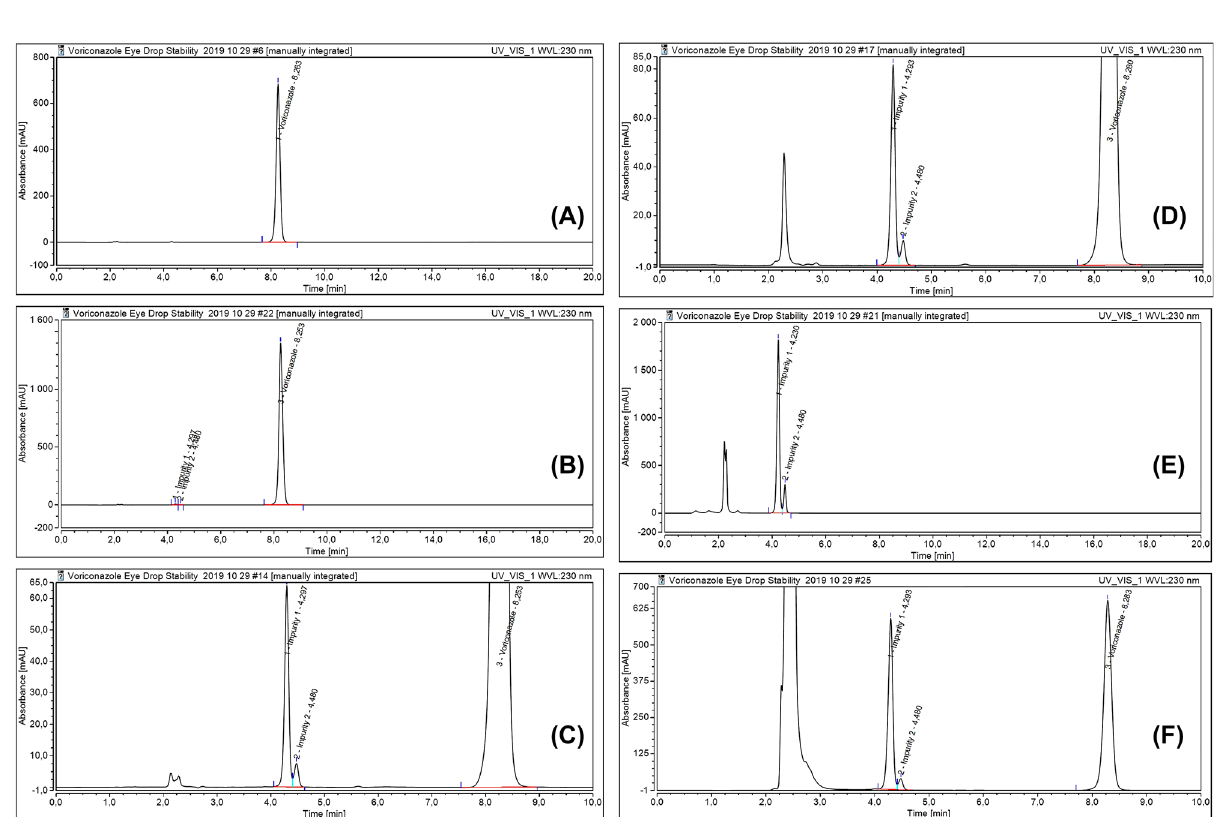
Figure1: Chromatogramsofvoriconazolereferencesolution(A),anddegradationproductsafterstressedconditionsUV(B),70 ° Cdryheat(C),